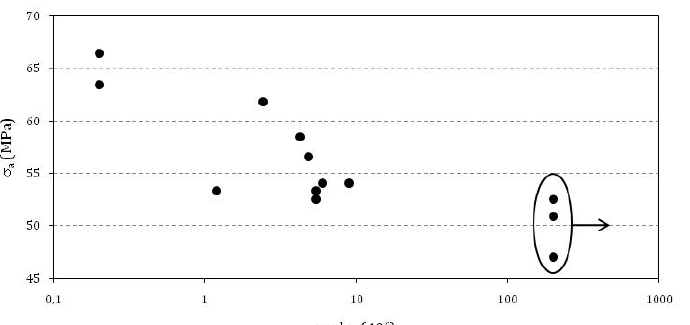
Figure 11: S-N curve (Wöhler diagram) summarizing the results of fatigue tests on shear and flexural specimens. The number of cycles to failure is reported for each specimen in relation to the axial stress amplitude calculated by the FEM model.